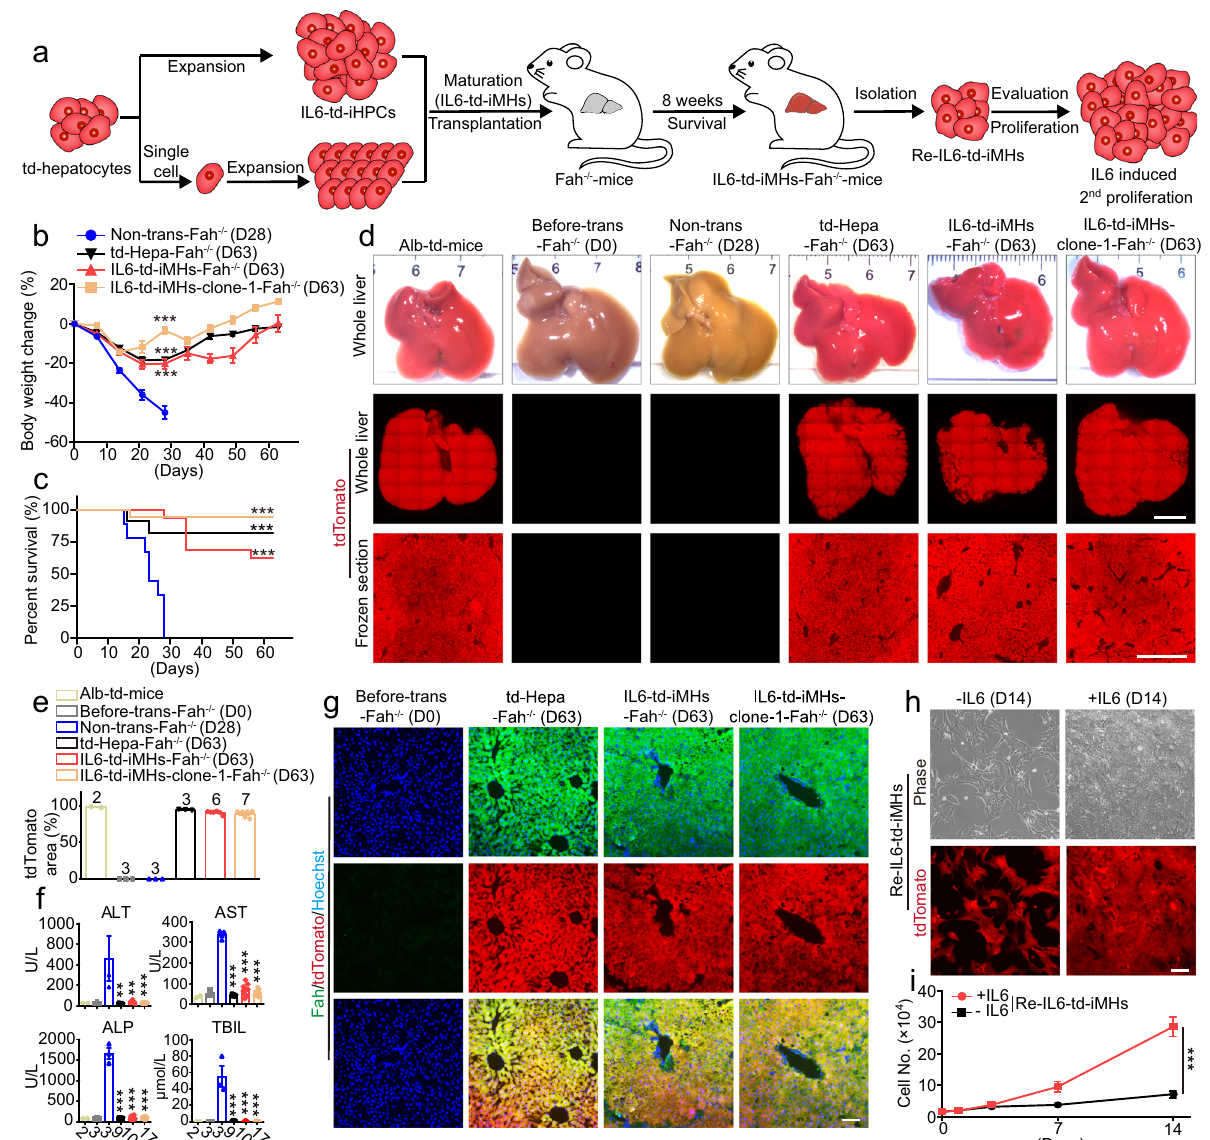
Fig.4|IL6derivediMHsrepopulateliversofFah − / − mice.a Schematicdiagramof theexperimentalprocedure:td-iMHsmaturedfromIL6-expandedtd-iHPCs(mixed populationorsingle-cellclones)weretransplantedintotheliverof Fah − / − mice,and therepopulatedtd-iMHswereisolatedagain8weekslaterandtestedfor2ndround of expansion with IL6. b Body weight change of Fah − / − mice (no NTBC) receiving vehicle (Non-trans, n =9 mice), primary td-hepatocytes (td-Hepa, n =11 mice), IL6- td-iMHs (P10, n =16 mice) and IL6-td-iMHs-clone-1 (P10, n =18 mice). Data are Means±SEM. Statistical differences between two groups were analyzed from D0 – D28. *** p <0.001 (two-way ANOVA). c Survival curves of the animals in b . *** p <0.001 (Log-rank test). d Representative images of the whole livers (top), and fl uorescent images of the whole livers (middle, scale bars represent 5mm) and frozen sections of liver (down, scale bars represent 1mm) from Fah − / − mice before NTBC withdrawal (D0, n =2 mice), 28 days after vehicle transplantation (no NTBC, n =3mice),or63daysaftertd-Hepa( n =3mice),IL6-td-iMHs( n =6mice),orIL6-td- iMHs-clone-1 ( n =7 mice) transplantation (no NTBC). The liver of Alb-td-mice was